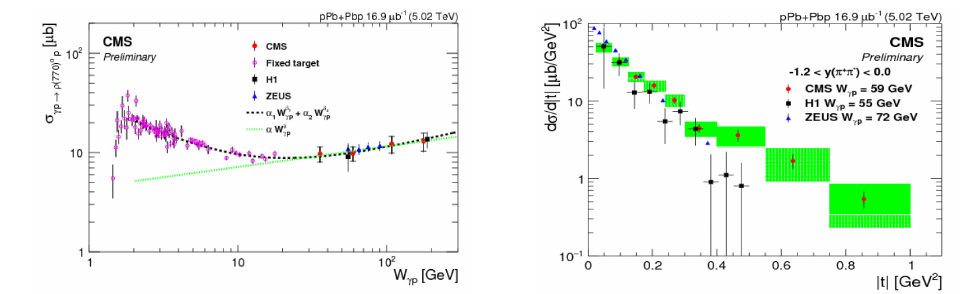
photoproduction as a function of < 0 (right) [6]. 𝜊𝜊 𝜌𝜌 (770) + − 𝜋𝜋 𝑠𝑠 𝜋𝜋